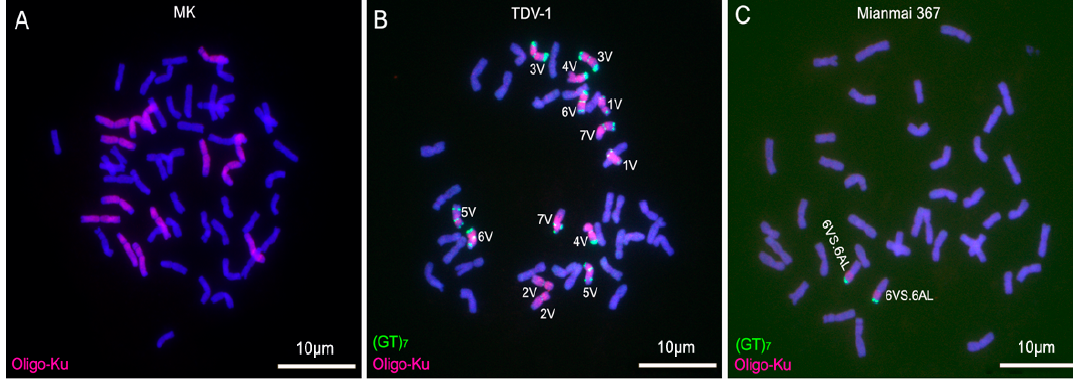
Figure 5. ND-FISH analysis using Oligo-Ku ( red ) and (GT) 7 ( green ) as probes. ( A ) Root tip metaphase chromosomes of Octoploid triticale MK; ( B ) Root tip metaphase chromosomes of wheat– D. villosum amphiploid TDV-1; ( C ) Root tip metaphase chromosomes of common wheat cultivar Mianmai 367.